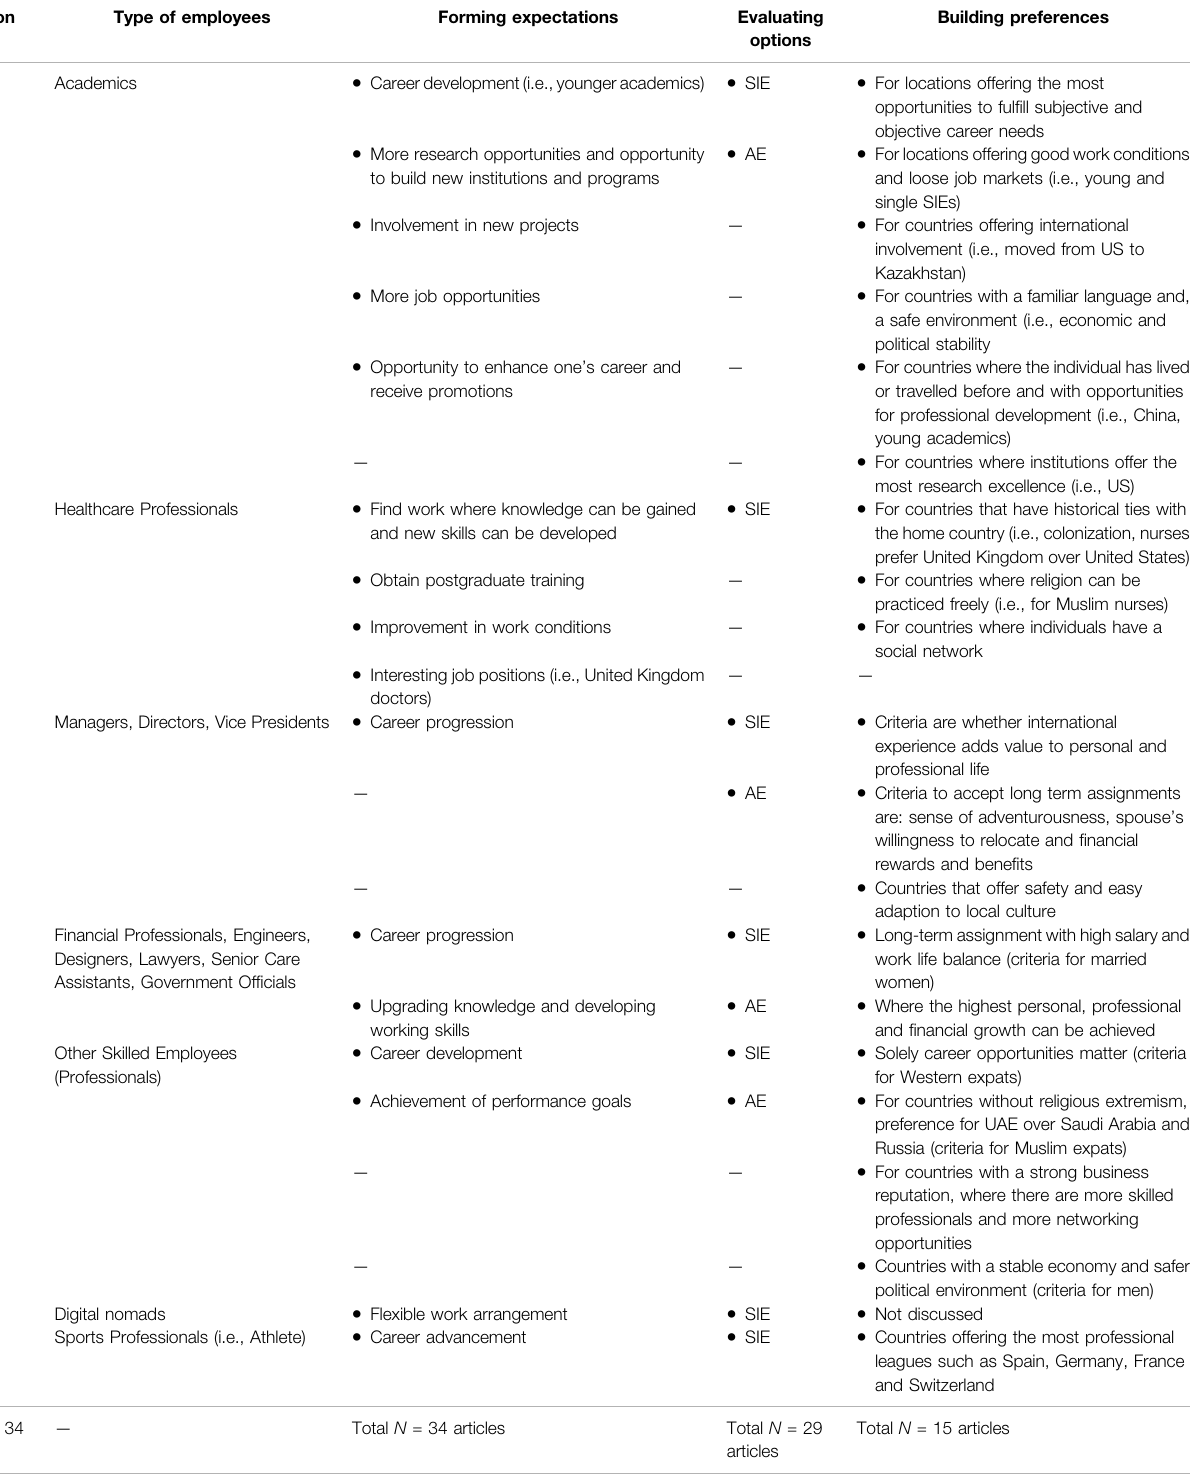
TABLE 2 | Overview of the motivation process for all four motivations and the different types of